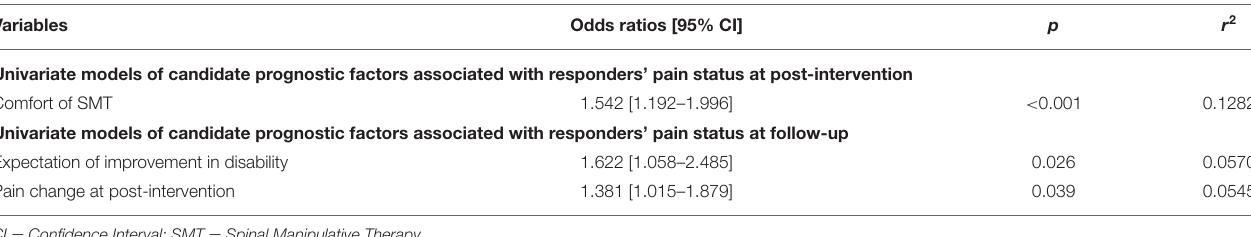
TABLE 5 | Univariate models of candidate prognostic factors associated with responders’ pain status at post-intervention and follow-up (Odds Ratios, confidence intervals and p -values). Variables Odds ratios [95% CI] p r 2 Univariate models of candidate prognostic factors associated with responders’ pain status at post-intervention Comfort of SMT